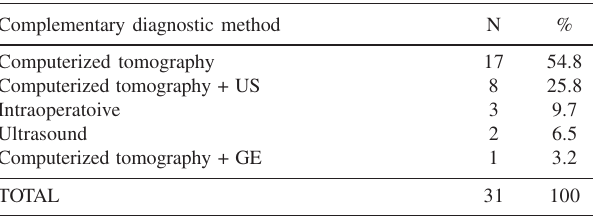
Table 3 - Diagnostic strategies after 1986 Complementary diagnostic method